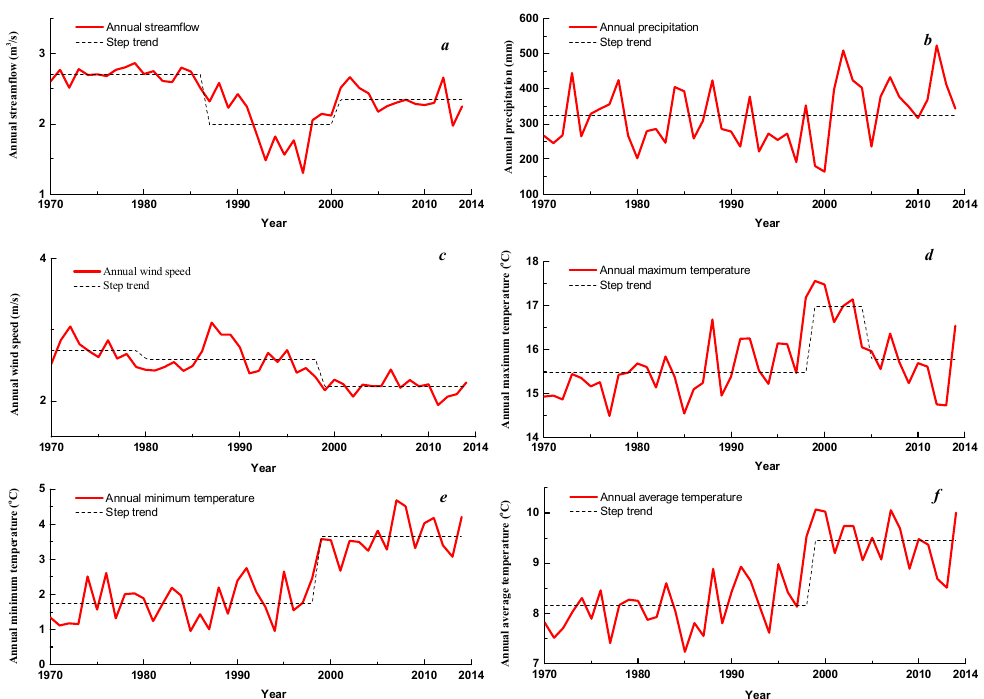
Figure 6. The ( a ) temporal variation of annual streamflow; ( b ) precipitation; ( c ) wind speed; ( d ) maximum temperature; ( e ) minimum temperature; and ( f ) average temperature of the Hailiutu River basin. The dashed lines are the step trends.